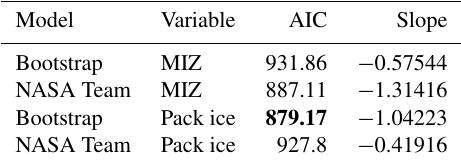
Table 5. Results of model selection for the relationship between pack ice and MIZ on breeding success of snow petrel. The model with the lowest AIC is highlighted in bold. AIC scores are often interpreted as difference between the best model (smallest AIC) and each model referred to as (cid:49) AIC. According to information theory, models with (cid:49) AIC<2 are likely (Burnham and Anderson, 2002), but if a model shows a (cid:49) AIC>4, it is unlikely in comparison with the best model (smallest